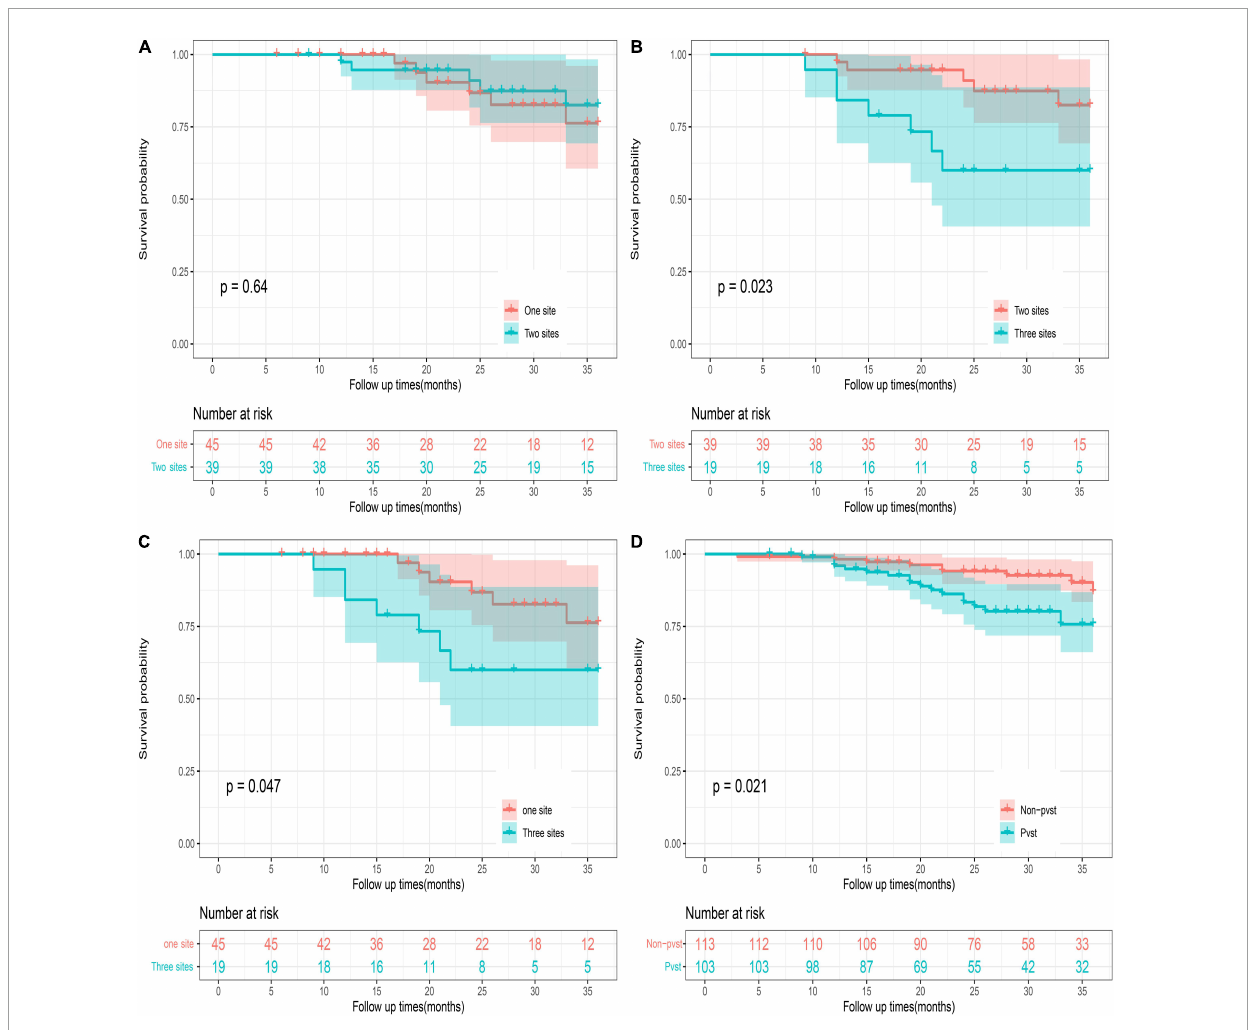
FIGURE8 36-month survival analysis of the patients with different numbers of sites of thrombosis. PVST patients represented portal vein thrombosis (left and right branches and main trunk) or/and splenic vein thrombosis or/and mesenteric thrombosis. One site represents portal vein thrombosis (left and right branches and main trunk) or splenic vein thrombosis, or mesenteric thrombosis. Two sites: portal vein thrombosis (left and right branches and main trunk) and splenic vein thrombosis; portal vein thrombosis (left and right branches and main trunk) and mesenteric thrombosis; splenic vein thrombosis and mesenteric thrombosis. Three sites: portal vein thrombosis (left and right branches and main trunk) and splenic vein thrombosis + mesenteric thrombosis. Survival of patients with PVST after surgery: (A) One site versus two sites. (B) Two sites versus three sites. (C) One site versus three sites. (D) PVST versus